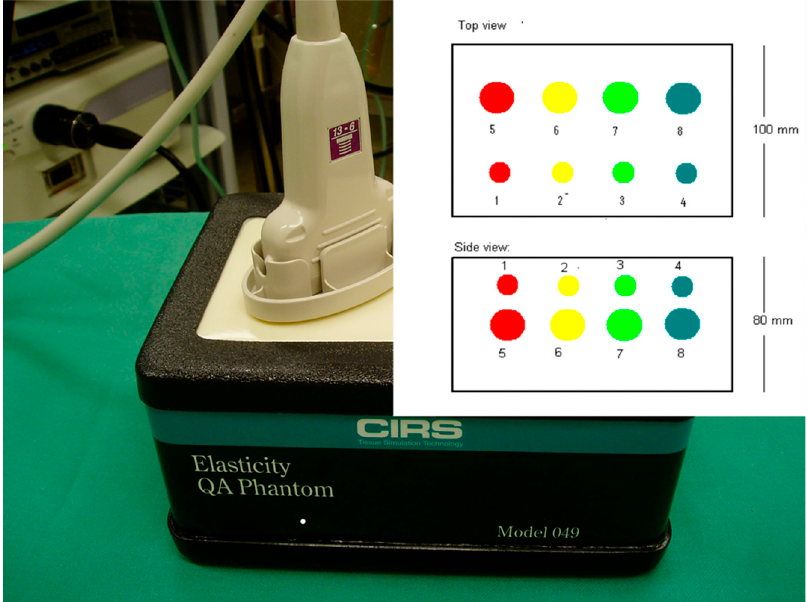
Figure 1. The Zerdine phantom used for scanning with a visualization of the inclusions inside. Red lesions: 8 kPa, yellow: 14 kPa, green: 45 kPa, and blue: 80 kPa in a background of 25 kPa.